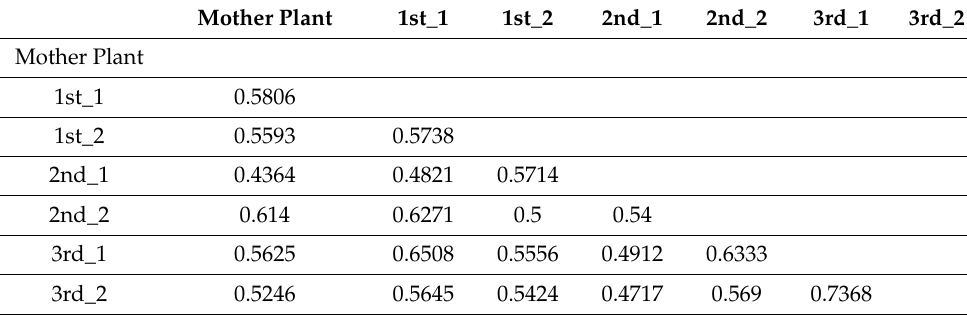
Figure 5. UPGMA dendrogram based on data generated from biochemical and molecular markers, showing the genetic linkage distance among the different micropropagated plantlets in different generations of L. schweinfurthii . MP, mother plant; 1st, first-generation plantlets; 2nd, second-generation plantlets; 3rd, third-generation plantlets. Table 3. Jaccard’s similarity coefficient concerning similarities in DNA fragments generated in RAPD and ISSR analyses and protein polypeptides through SDS-PAGE.